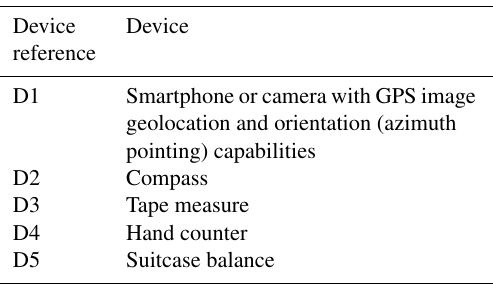
Table 1. Devices required to perform strong-convective-wind dam- age